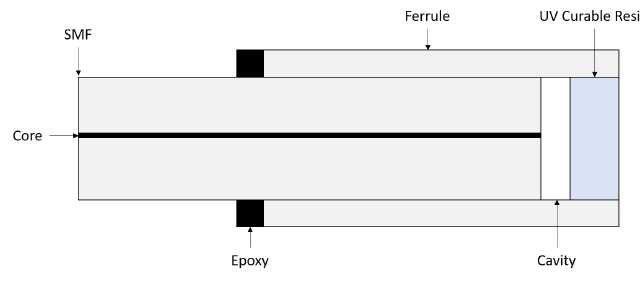
Figure 5. Schematic of EFPI sensor based on Zhang et al. (Adapted from ref.